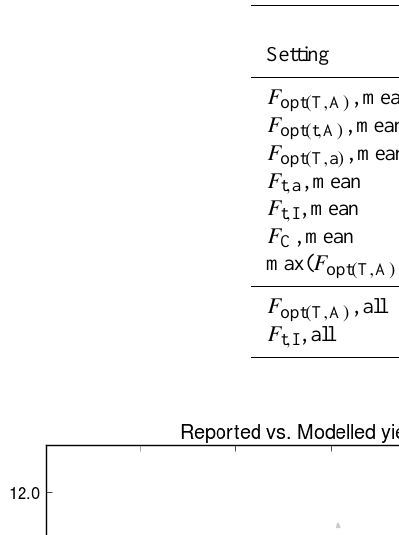
Table 5. Slopes, intercepts and R 2 values for regressions comparing the simulated yields using the model setups described in Table 3, against reported yields for the 65 NUTS2 level regions. RMSE values and Willmott index ( W i ) are provided, the number of data points used to derive the statistics “all” were 1400 (all regions and years).